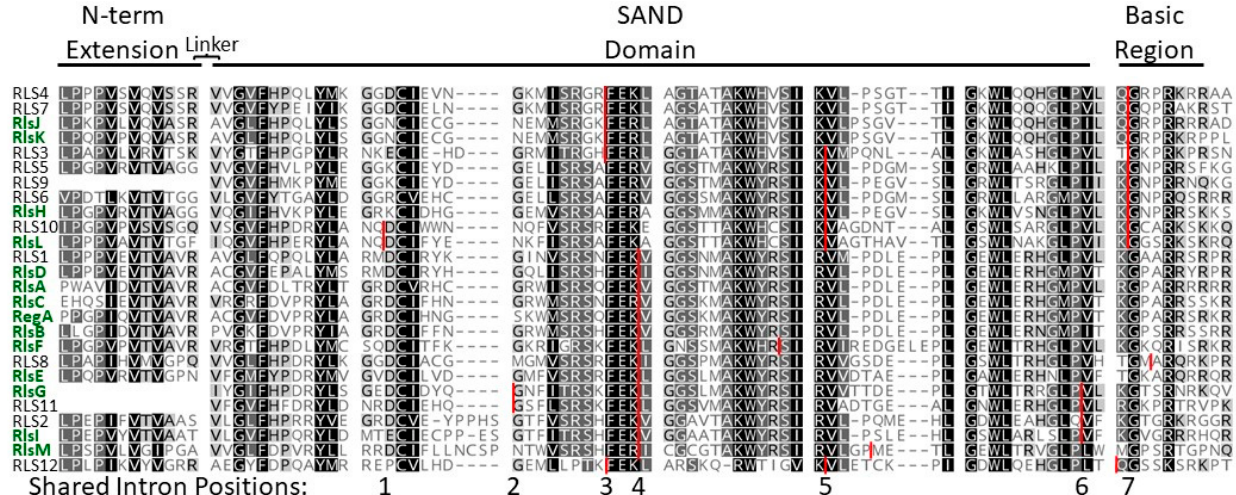
Figure 4. Alignment of VARL domains in C. reinhardtii and V. carteri . Names of V. carteri VARL domains are shown in bold green font. Conserved regions are annotated above alignment. Variable linker region between N-terminal extension and core VARL SAND domain not shown. Vertical red lines indicate conserved intron positions. Figure adapted from the paper by Duncan et al. [59].